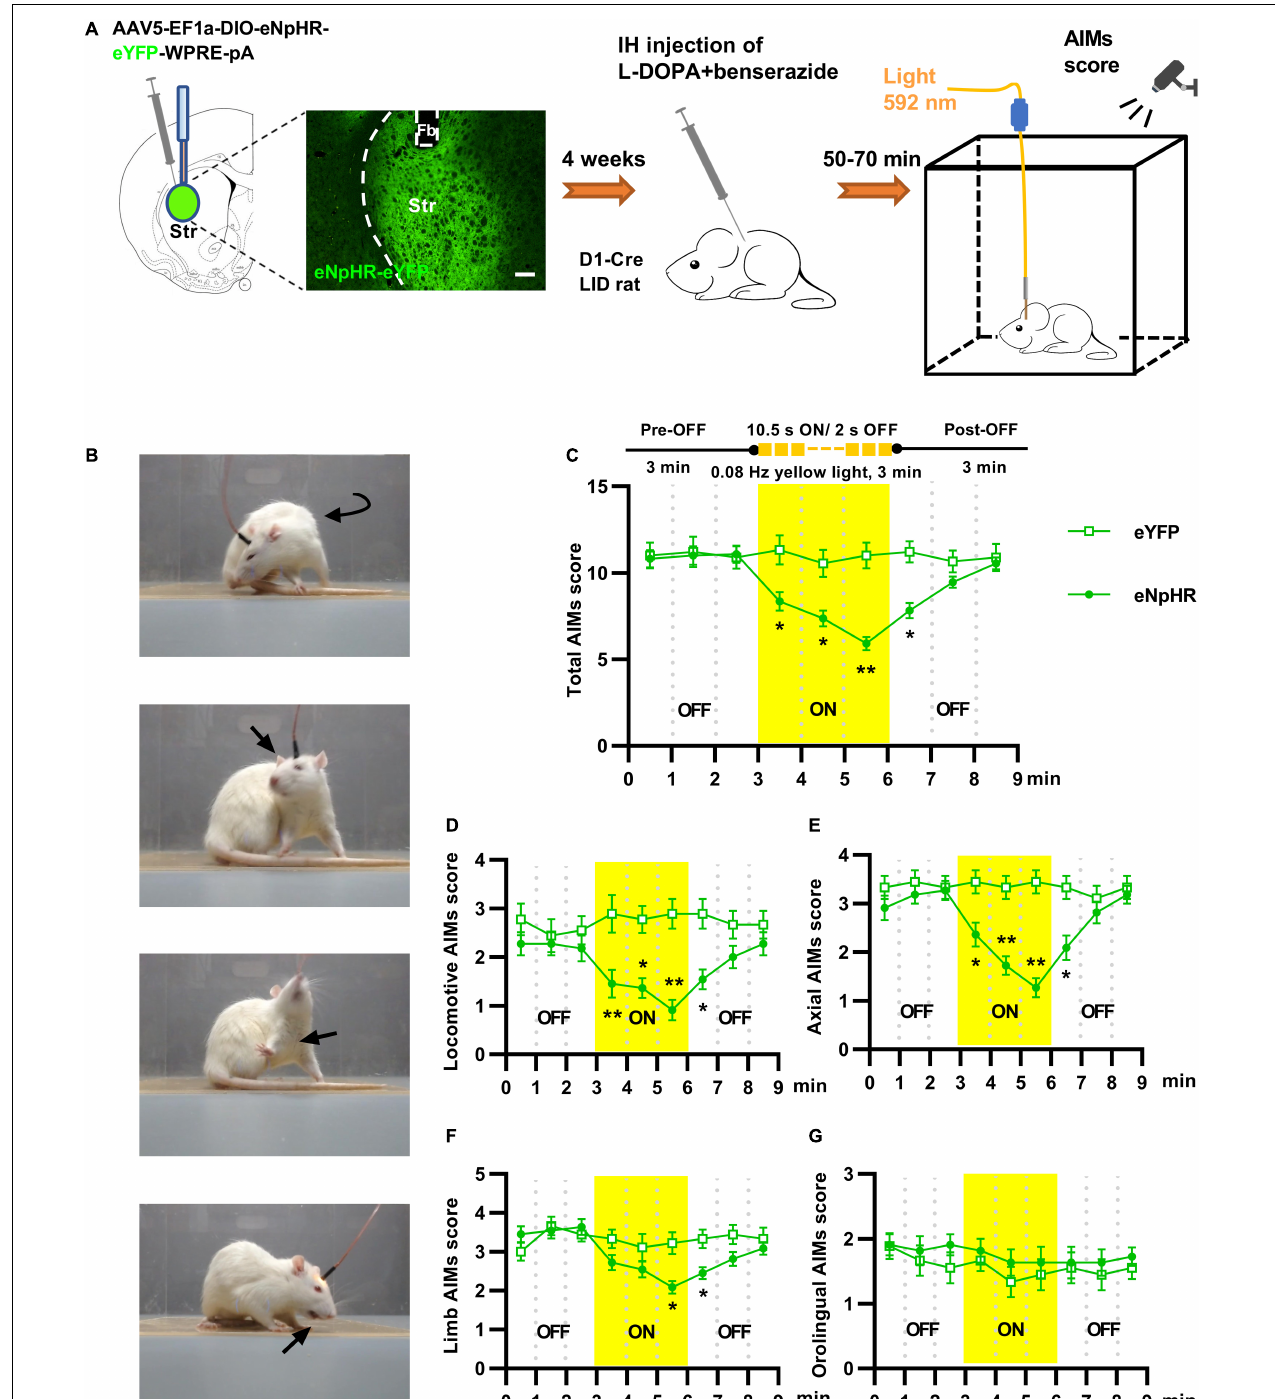
FIGURE 3 | Optogenetic inhibition of striatal D 1 + neurons suppressed abnormal involuntary movements of rats with levodopa-induced dyskinesia (LID). (A) Experimental design of the optogenetic assay using stereotaxic injection of Cre-dependent AAV to express eNpHR 3 . 0 or eYFP in striatal D 1 + neurons (scale bar = 200 µ m). (B) Photographs from LID rats affected by locomotive, axial, forelimb and orolingual abnormal involuntary movements. (C) Change in the total Abnormal Involuntary Movement scale (AIMs) scores before, during, and after striatal yellow light (592 nm) in eNpHR3.0 or eYFP rats [ n = 11 for eNpHR group and n = 9 for eYFP control; two-way repeated measures analysis of variance (ANOVA) with post-hoc Holm-Sidak method: F ( 1 , 18 ) = 5.910, P = 0.026; * P < 0.05, ** P < 0.01]. Effects of striatal yellow light on locomotive (D) , axial (E) , forelimb (F) and orolingual (G) AIMs score (two-way repeated measures ANOVA with post-hoc Holm-Sidak method; (D) F ( 1 , 18 ) = 10.389, P = 0. 005 ; (E) F ( 1 , 18 ) = 9.821, P = 0.006; (F) F ( 1 , 18 ) = 3.649, P = 0.072; (G) F ( 1 , 18 ) = 1.219, P = 0.284; * P < 0.05, ** P < 0.01.